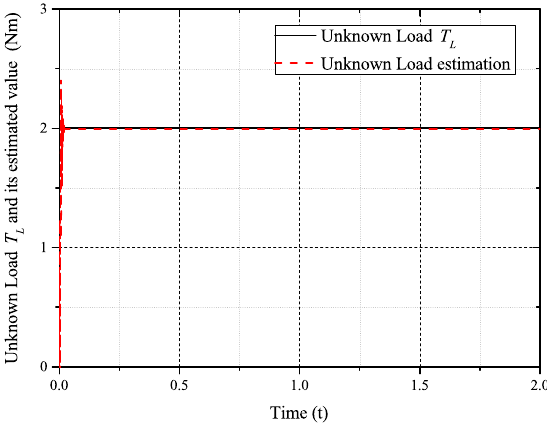
Figure 15. Unknown load disturbances T L and its estimated value ˆ T L